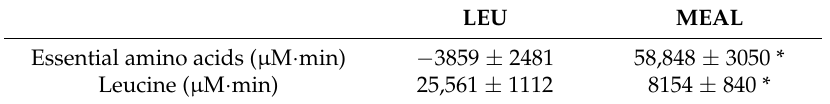
Table 6. Area under the curve with respect to increases for essential amino acids and leucine for LEU and MEAL.